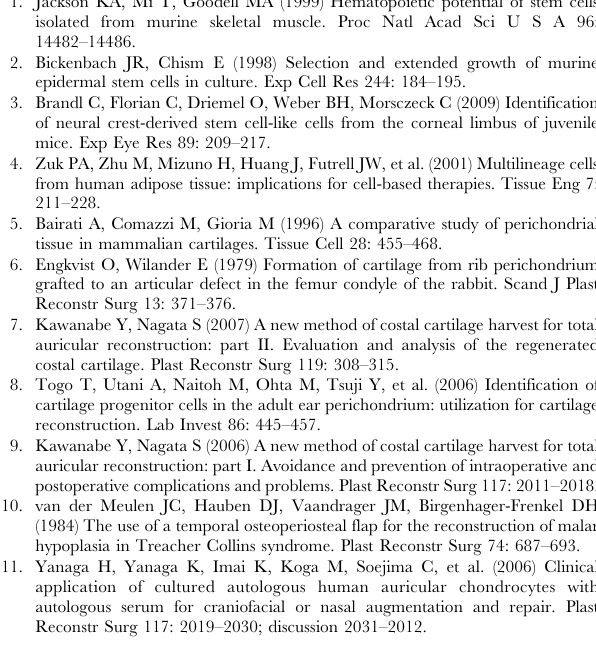
Figure S1 BrdU labeling of auricular cartilage in a 4- week-old mouse. 4-week-old mice were injected with BrdU and were sacrificed the day. None of BrdU-labeled cells and Ki67- positive cells were observed in both the perichondrium and chondrium of an auricular cartilage. From the left, Alcian blue staining, DAPI, BrdU, Ki67, and a merged image. Two-headed arrows: the cartilage width including perichondrium. Scale bar =100 m m. (TIFF) Figure S2 Long-term LRCs specifically reside in auric- ular perichondrium. 24 (A) or 48 (B) weeks-old mice auricle were immunohistochemically examined. Although none of BrdU labering cells was recognized in chondrium, rare long-term LRCs specifically existed in perichondrium layer. Two-headed arrows: perichondrium width, but not chondrium of auricular cartilage. Arrowheads: long-term LRCs. Scale bars = 200 m m. (TIFF) Figure S3 Immunohistochemical analysis of cell surface marker proteins in a 24-week-old mouse. Perichondrocytes of 24-week-old mice expressed integrin- a 5 and CD44 (Arrow- heads). Chondrocytes expressed integrin- a 1,2,V,L and integrin- b 1. Two-headed arrows: the cartilage width including perichon- drium. Scale bar =50 m m.